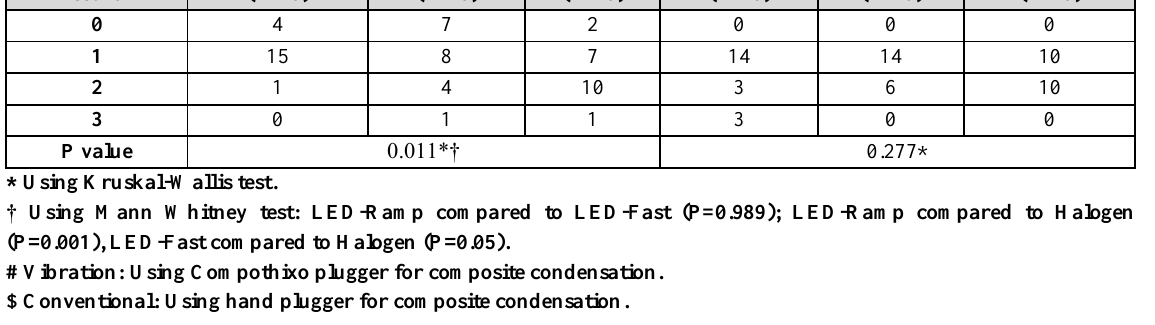
Table 3: Microleakage scores of vibration and conventional condensation methods using three light curing methods. Microleakage